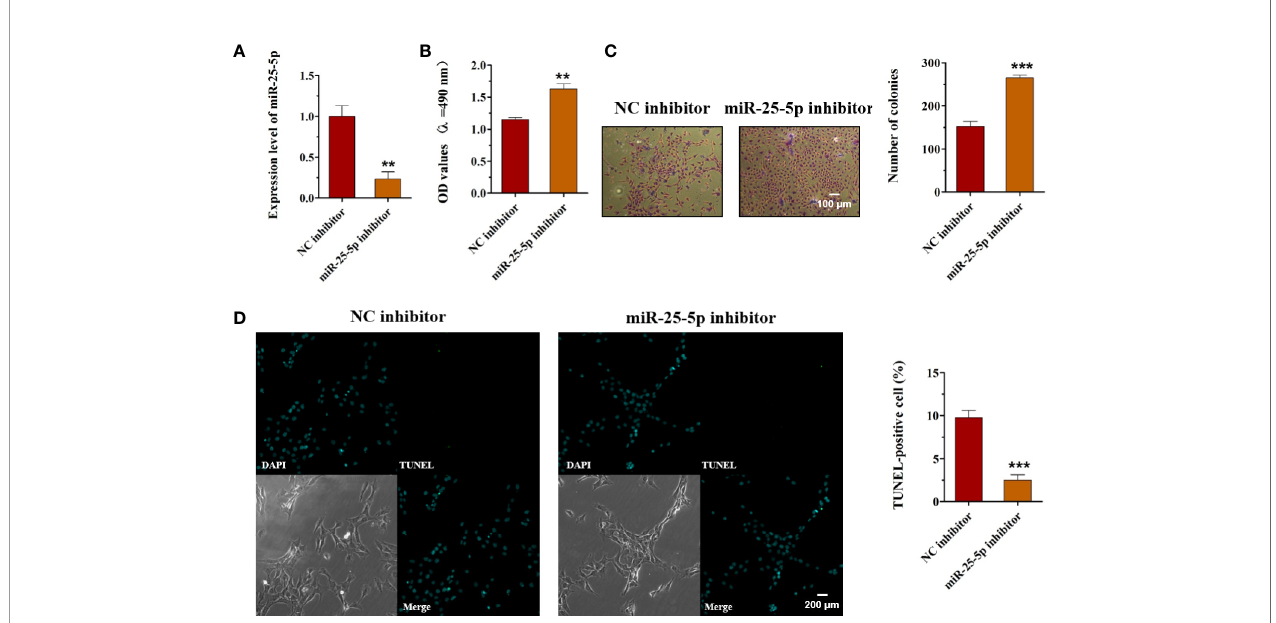
FIGURE 5 | Knockdown of miR-25-5p promotes cell viability, proliferation, and inhibits the apoptosis of OSCC cells. (A) SCC9 cells transfected with miR-25-5p or NC inhibitor were used to analyze the expression of miR-25-5p with RT-qPCR. (B) MTT assay of cell viability in SCC9 cells in the presence of miR-25-5p or NC inhibitor. (C) Effect of miR-25-5p inhibitor on the proliferation ability of SCC9 cells (Scale bar, 100 m m). (D) The apoptosis of SCC9 cells detected by TUNEL staining. Nuclei were stained by DAPI (blue) stain and apoptotic cells were stained by TUNEL (green) (Scale bar, 200 m m). (n=4, Student ’ s t-test, **p < 0.01 ***p <